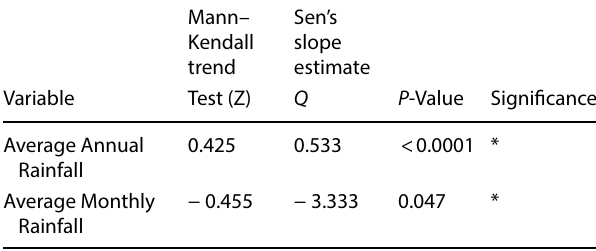
Table 4 Trend Analysis for Peshawar Station from 1960 to 2020. Source : Pakistan Meteorological